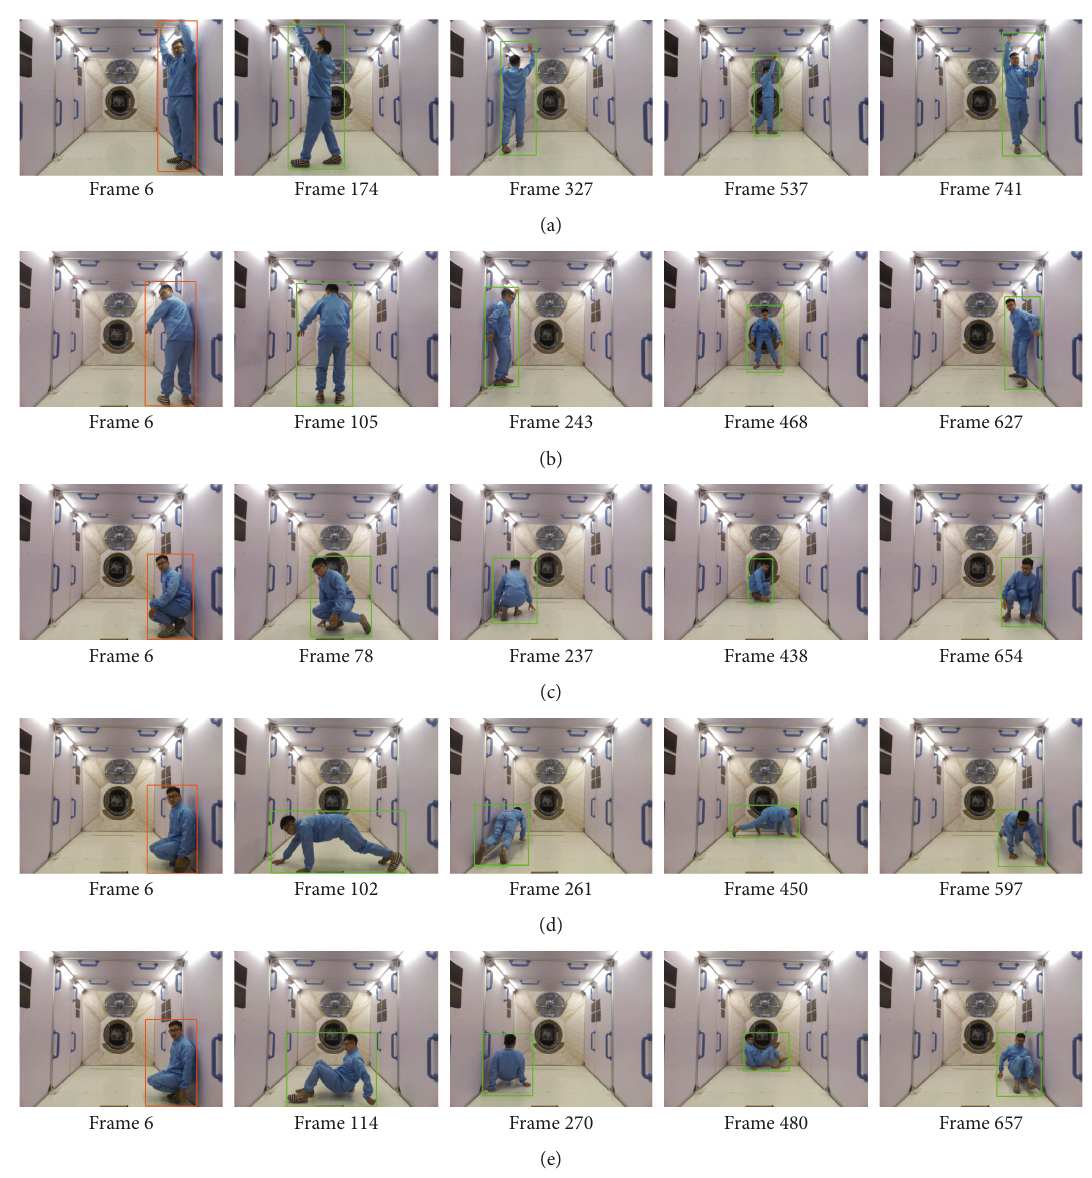
Figure 15: Follow a reference path with fi ve di ff erent